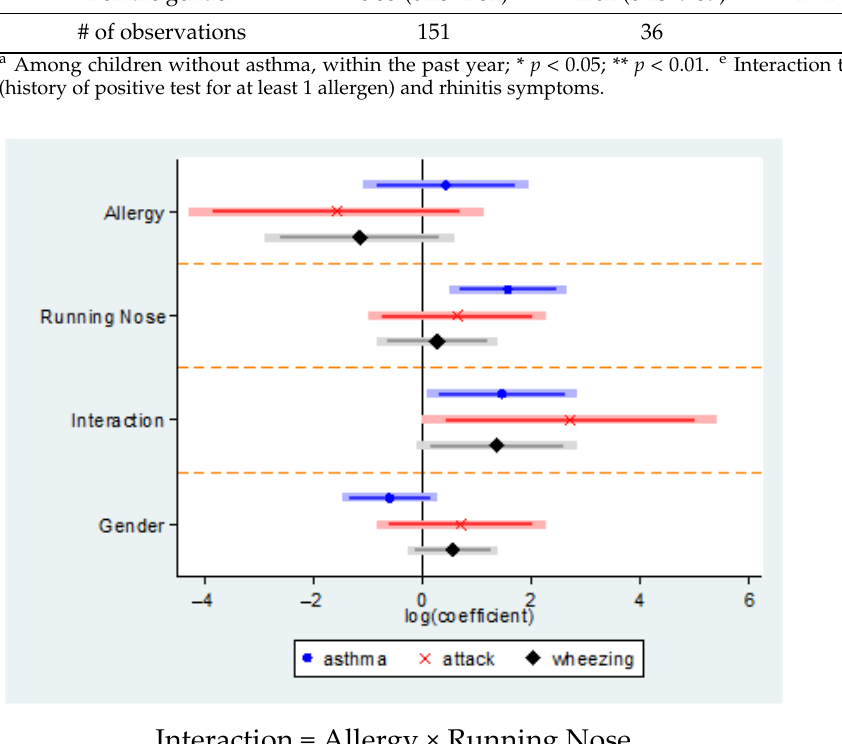
Table 5. Factor loadings with main outcome variables.